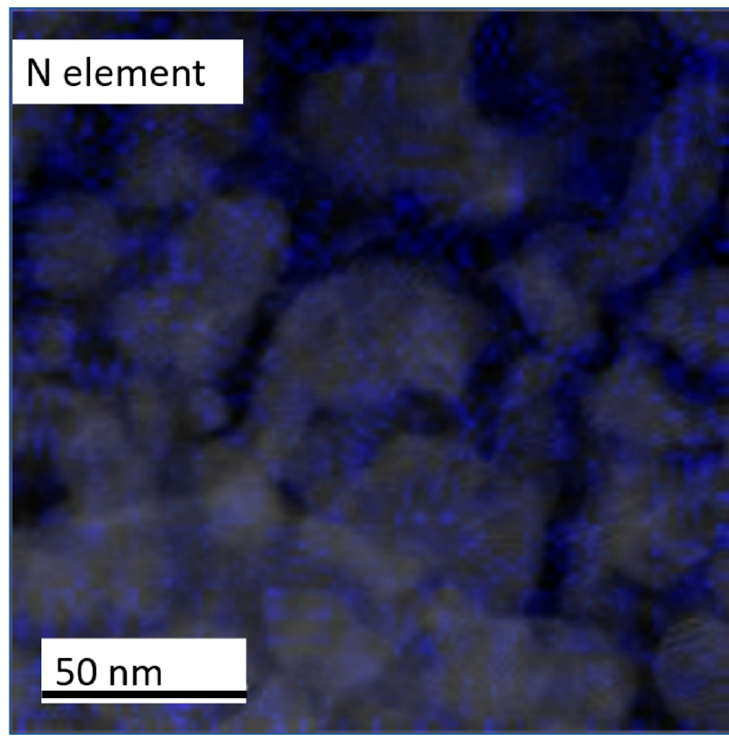
Figure 10. EELS mapping of grains image and N elements (indigo color).